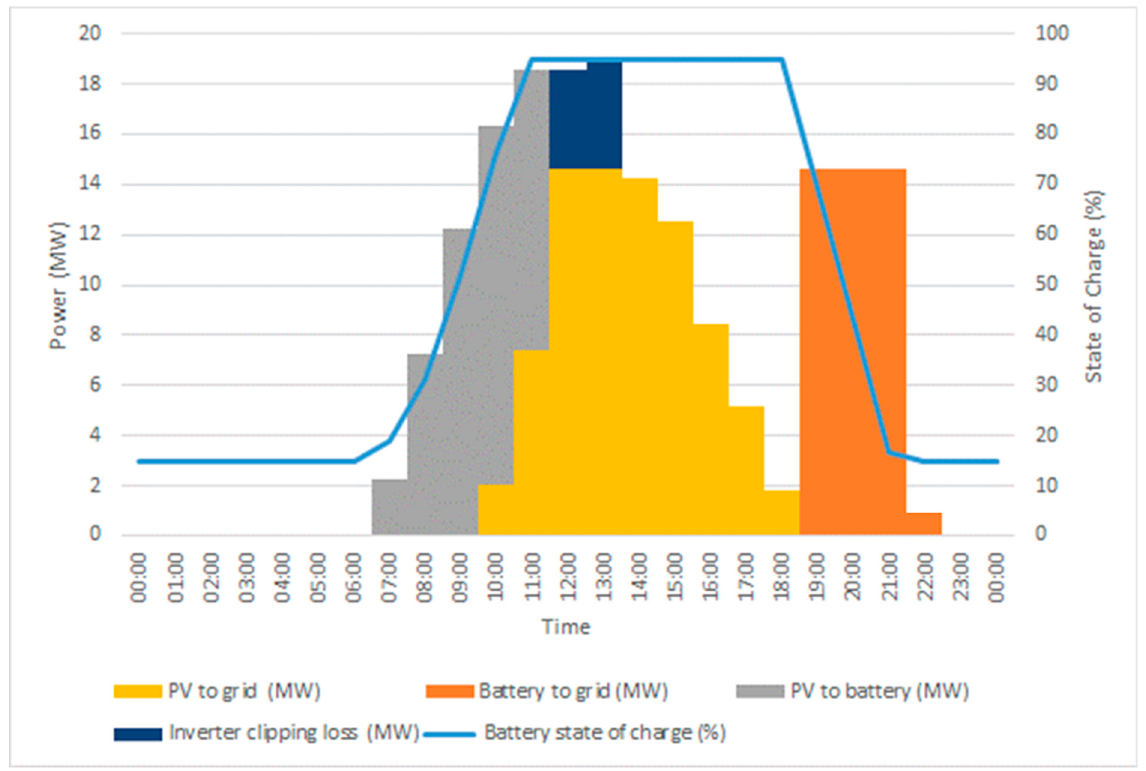
Figure 8. Power generation profile for fixed-tilt system with storage of 3 h and ILR = 1.6.